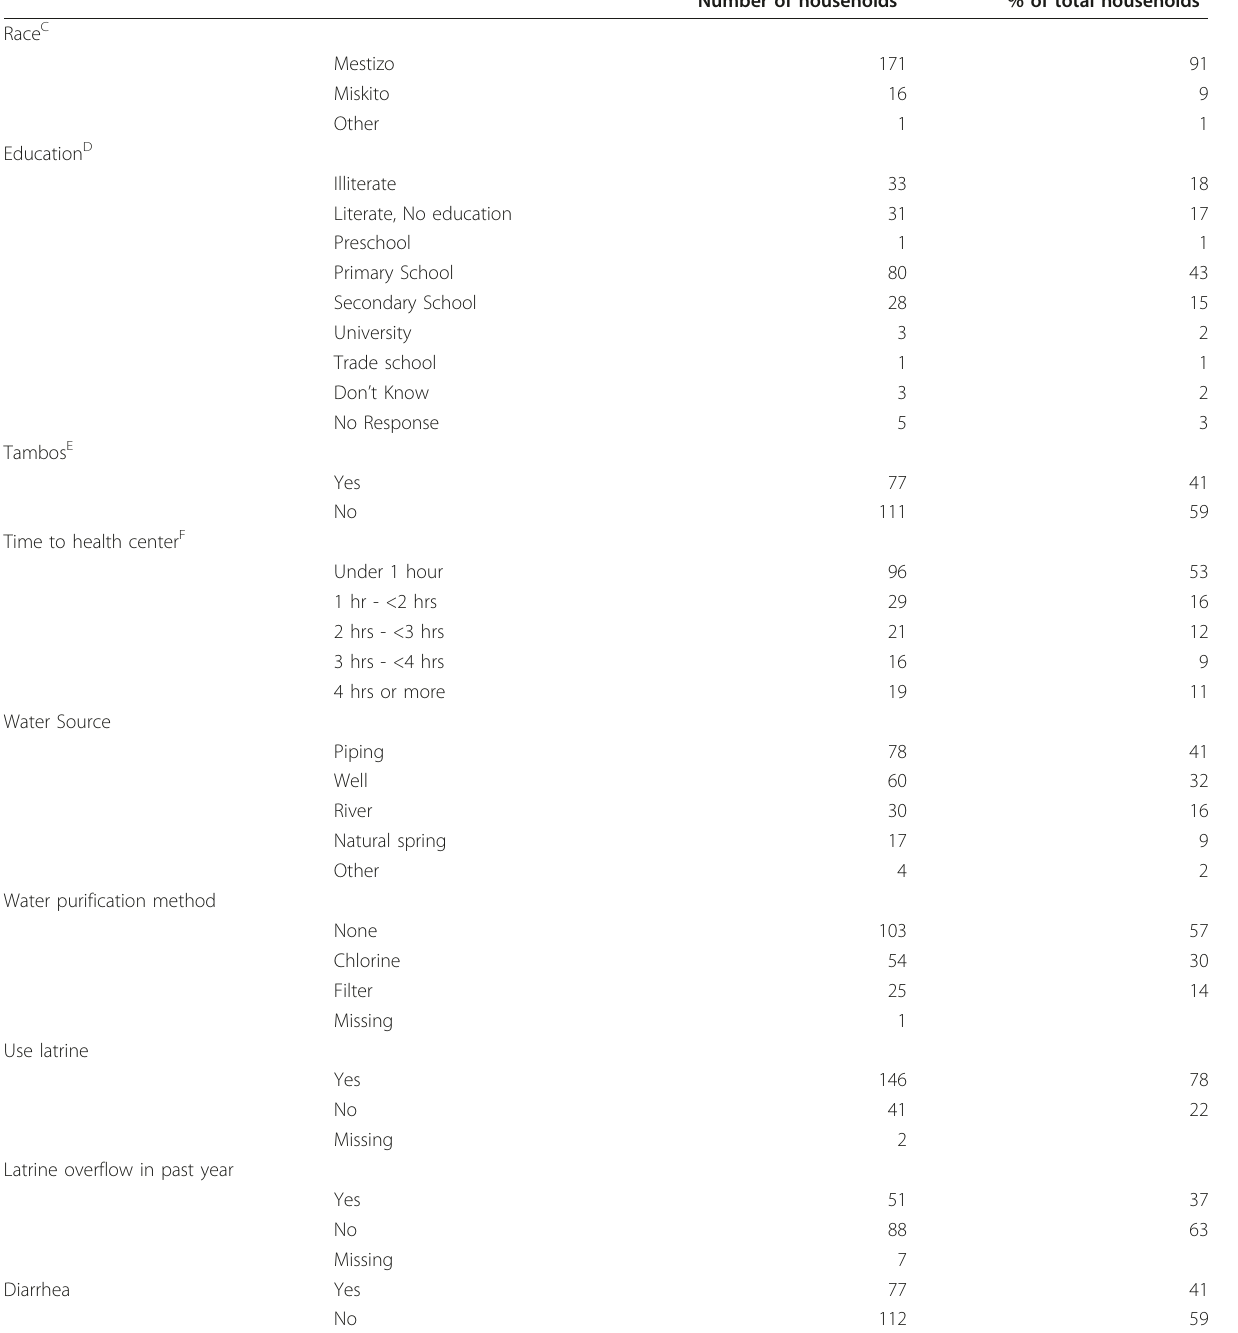
Table 1 Characteristics of Study participants in the Collaborative Sahsa Health Initiative in the North Atlantic Autonomous Region, Nicaragua, 2009 (N =